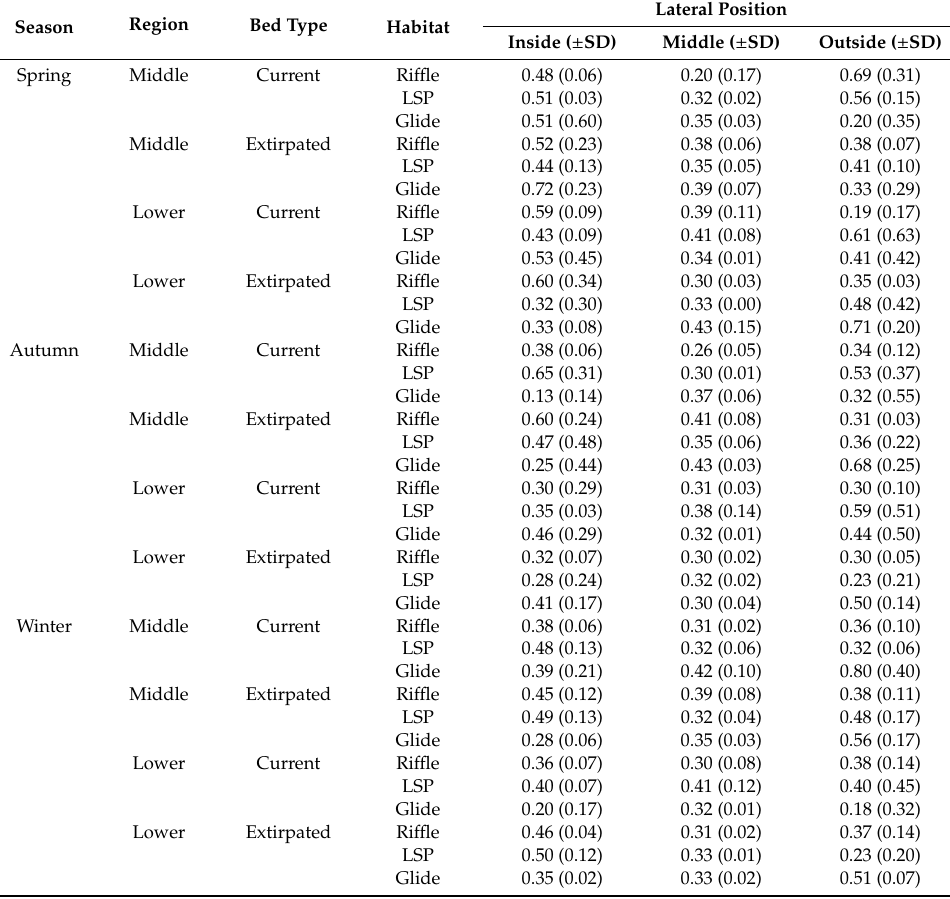
Table A7. Pooled mean particle size (mm) ( ± SD) by lateral position (Inside, Middle, Outside) across seasons (Spring, Autumn, Winter), regions (Middle, Lower), bed type (Current, Extirpated), and habitat (Ri ffl e, LSP,